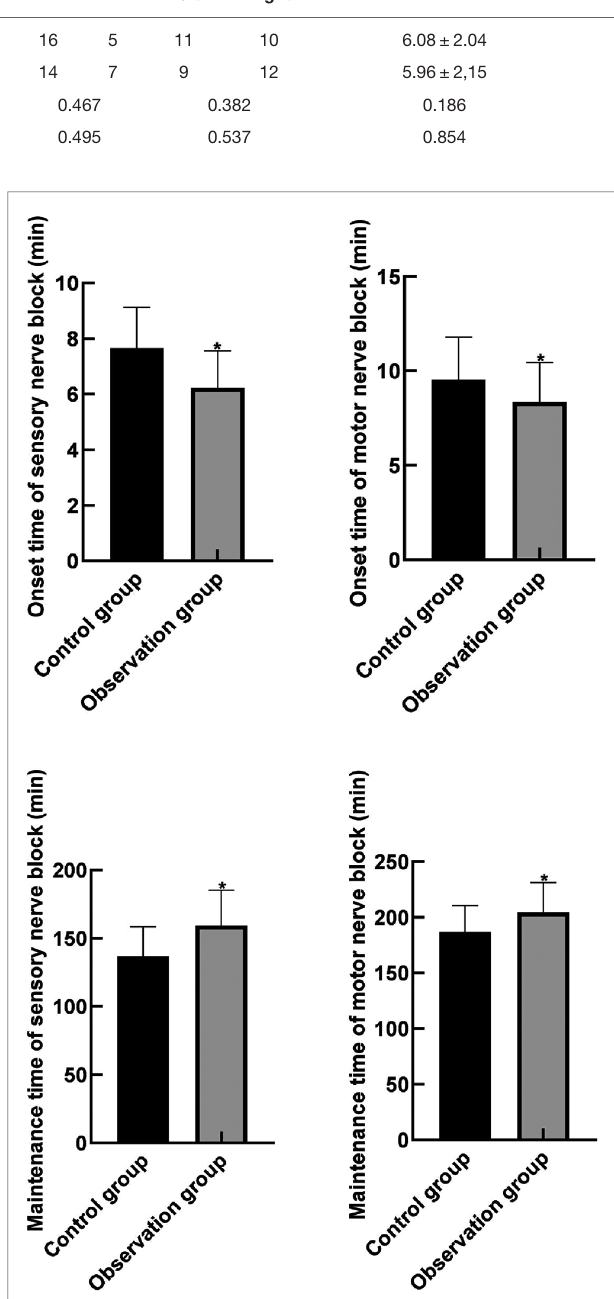
FIGURE 1 | Comparison of anesthesia effect indexes between the two groups. Note: Compared with the control group, * P